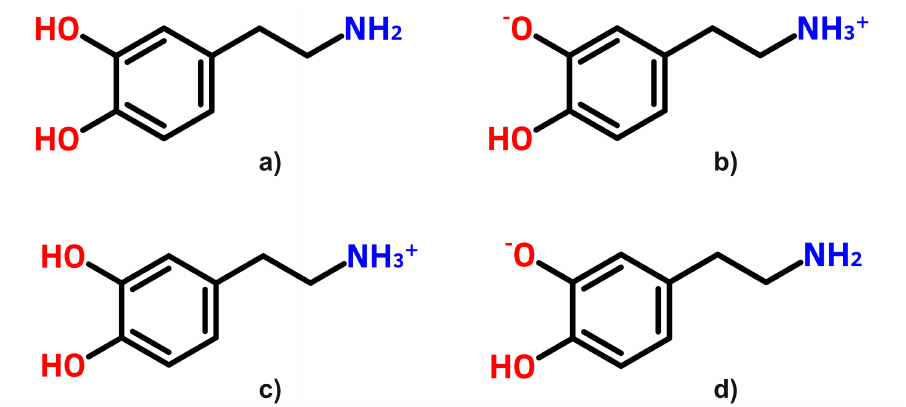
Figure 3. The chemical structure of the four dopamine conformations: ( a ) standard (or DA), ( b ) zwit- terionic (or DA zw ), ( c ) protonated (or DAH + ), and ( d ) deprotonated (or DAH − ),